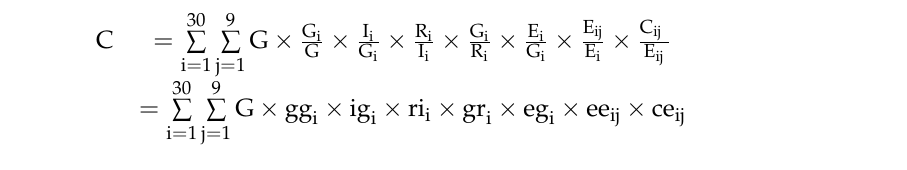
Table 1 summarizes the definitions of each variable used. Table 1. Variable